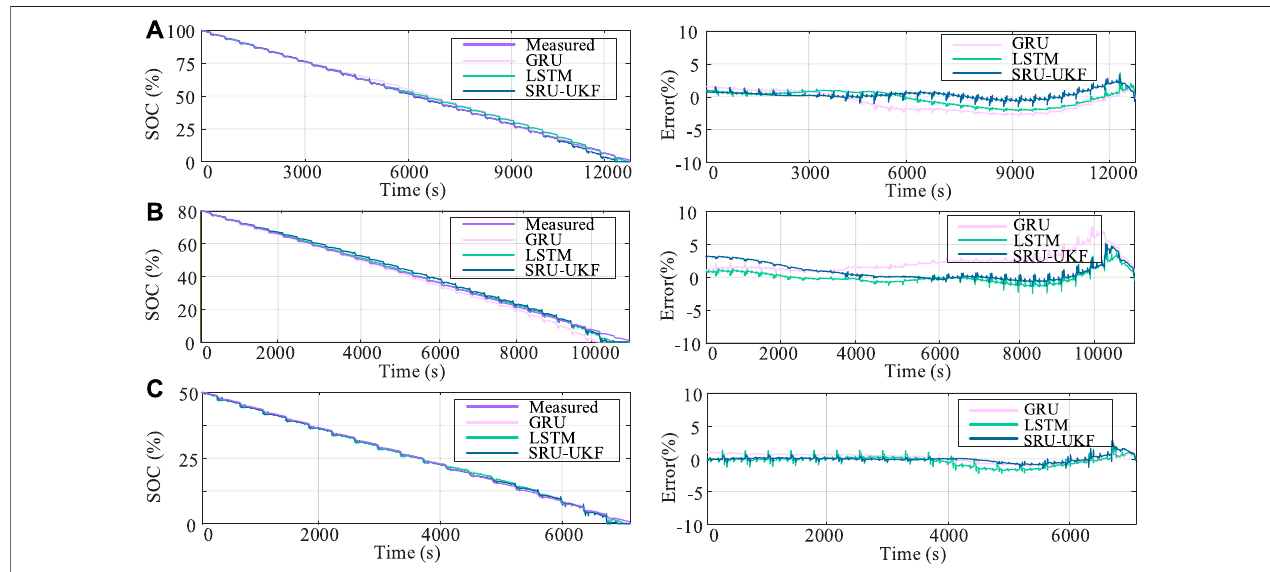
FIGURE 9 | Performance of GRU, LSTM, and SRU – UKF models with various initial SOC values: (A) 100%, (B) 80%, and (C) 50%.